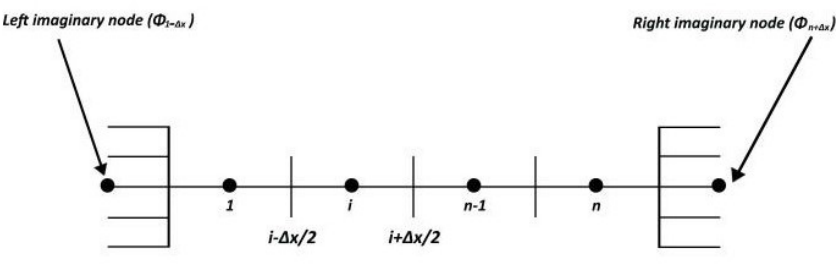
Figure 3. Indication of imaginary nodes for the treatment of boundary